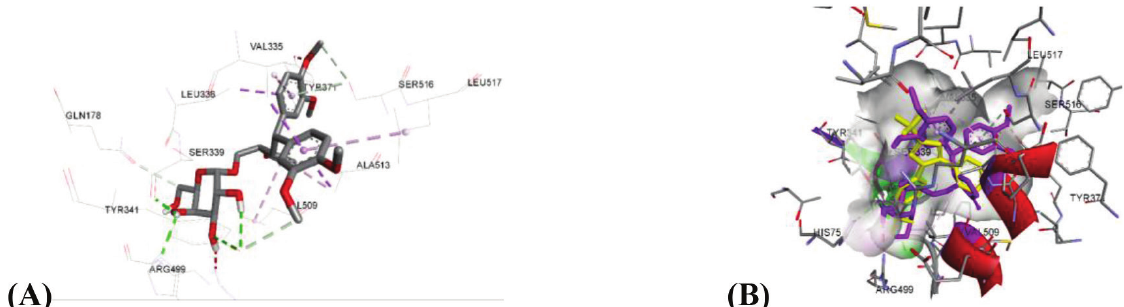
Figure 11. 3D visualization of ( A ) interaction of urticin A with amino acids residues of the active site of COX-2 inhibitor and ( B ) celecoxib compatible conformation (yellow molecule) and urticin A (purple molecule)